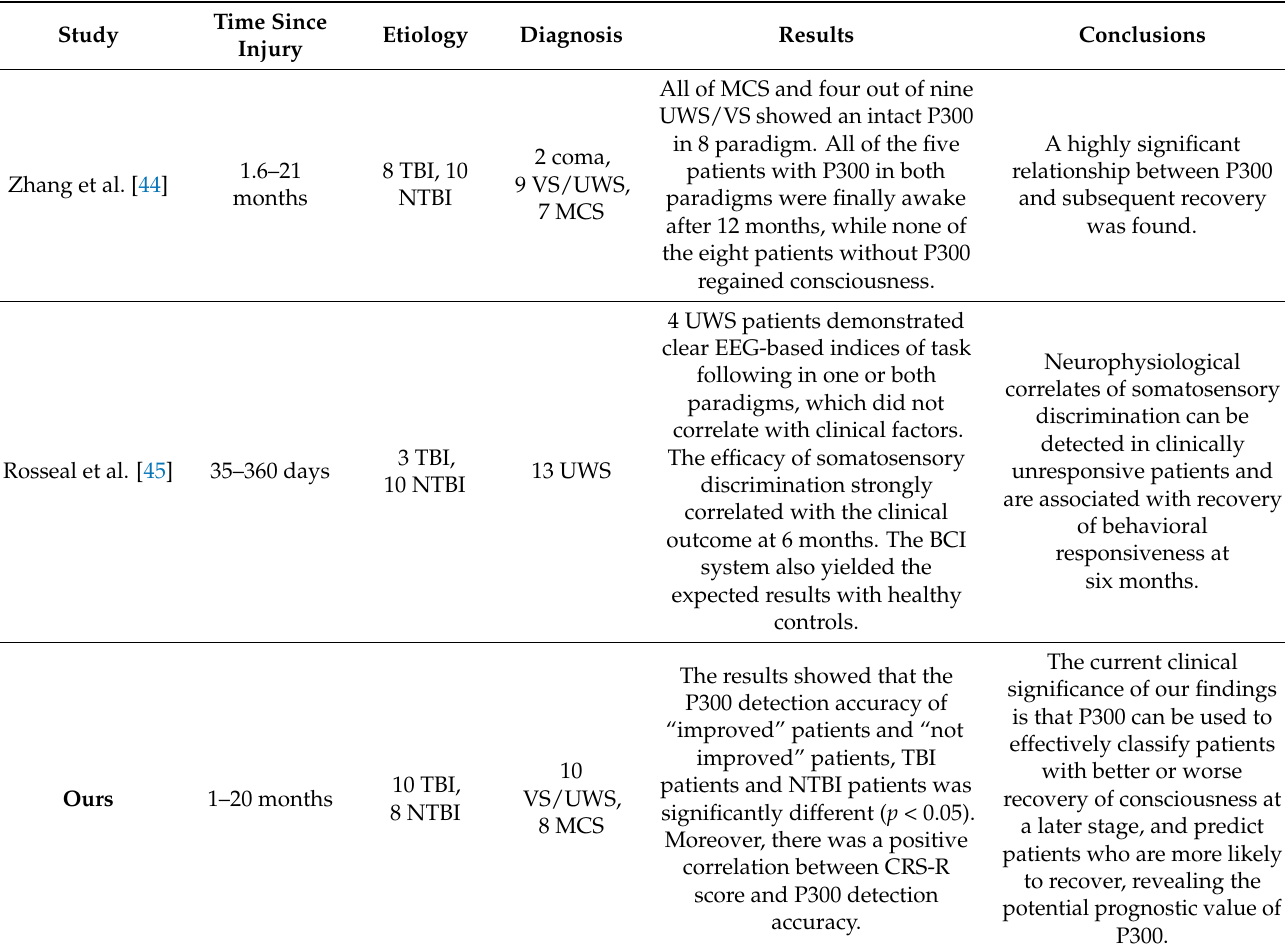
Table 7. A comparison of our study and other